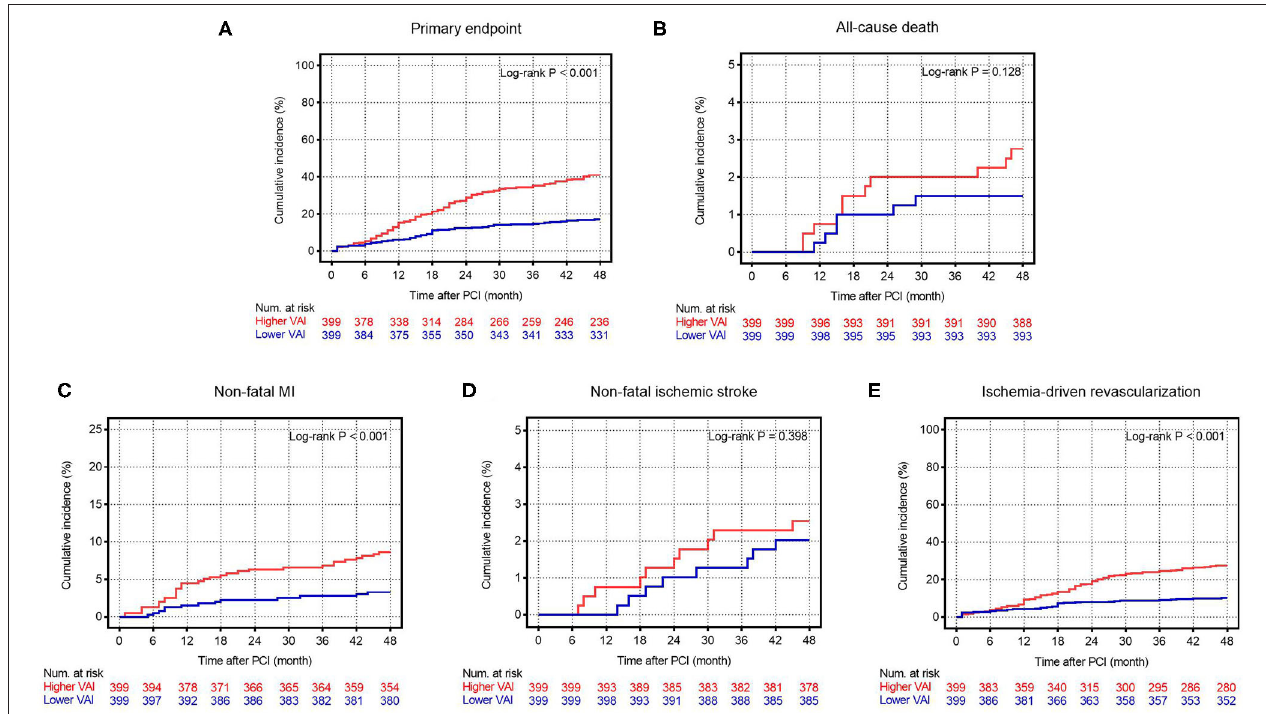
FIGURE 1 | The Kaplan–Meier survival curves according to the median of VAI. (A) The Kaplan–Meier survival curves for the primary endpoint; (B) The Kaplan–Meier survival curves for all-cause death; (C) The Kaplan–Meier survival curves for non-fatal MI; (D) The Kaplan–Meier curves for non-fatal ischemic stroke; (E) The Kaplan–Meier curves for ischemia-driven revascularization. VAI, visceral adiposity index; PCI, percutaneous coronary intervention; MI, myocardial infarction. model 5: HR 2.72, 95% CI 2.02–3.68, p < 0.001), non-fatal MI (unadjusted: HR 2.96, 95% CI 1.56–5.61, p < 0.001; fully adjusted model 5: HR 3.08, 95% CI 1.54–6.19, p = 0.002), and